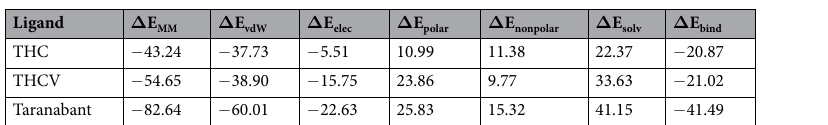
Table 1. Binding free energy components for the inactive CB1-ligand complexes determined by using the MM/ PBSA method.